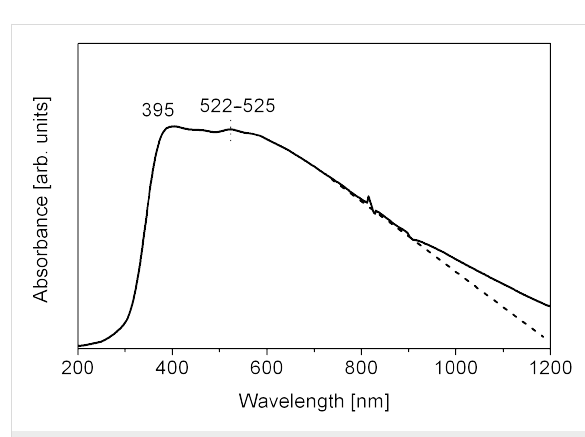
Figure 6: The absorption spectrum of polycrystalline CuInSe 2 nanorods.